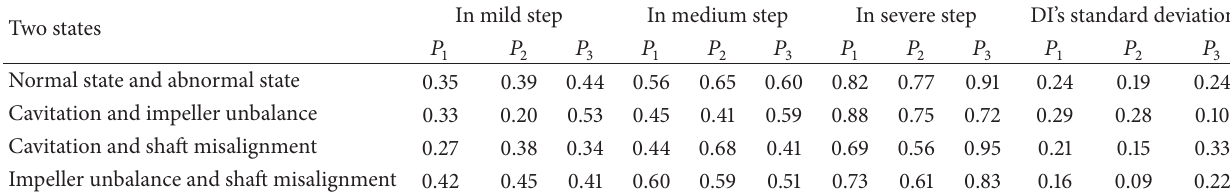
Impeller unbalance and shaft misalignment 0.42